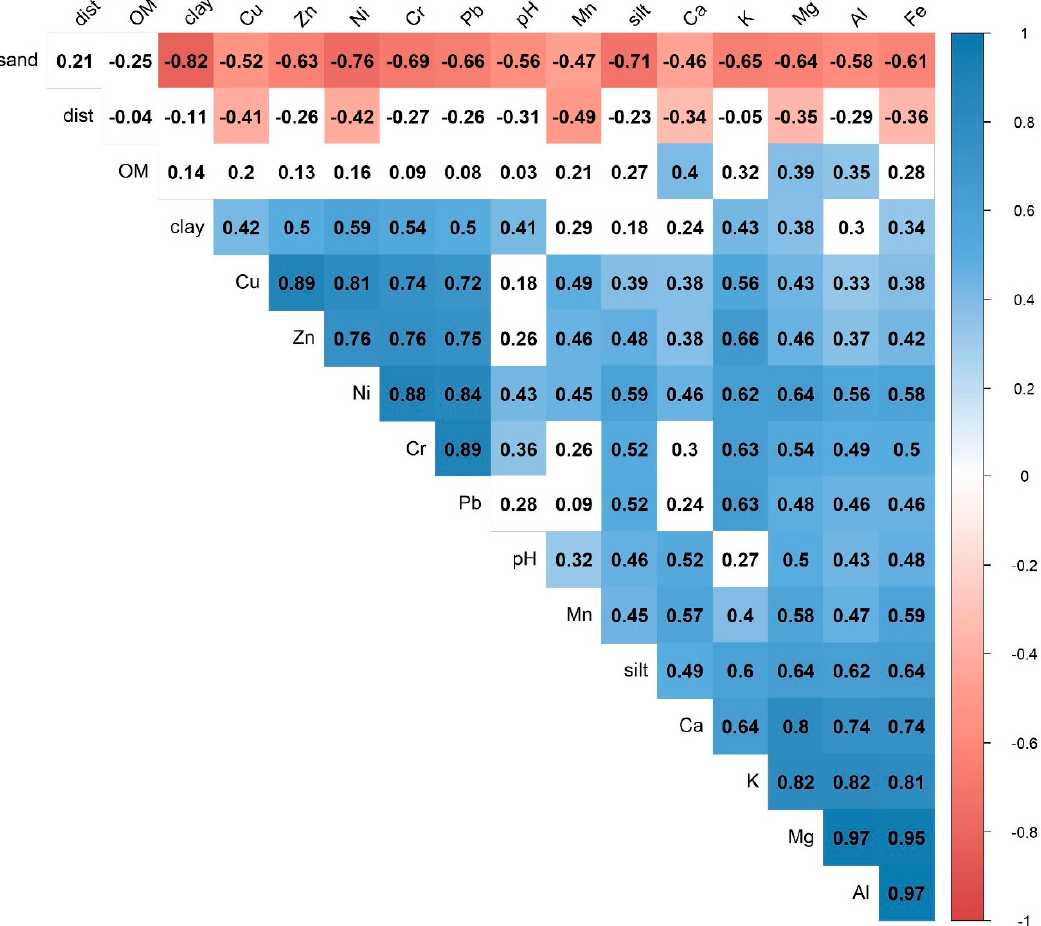
Figure 4. Connections between heavy metals (mg / kg) and soil properties (OM: Organic matter, %; dist: distance from the Tisza riverbank).